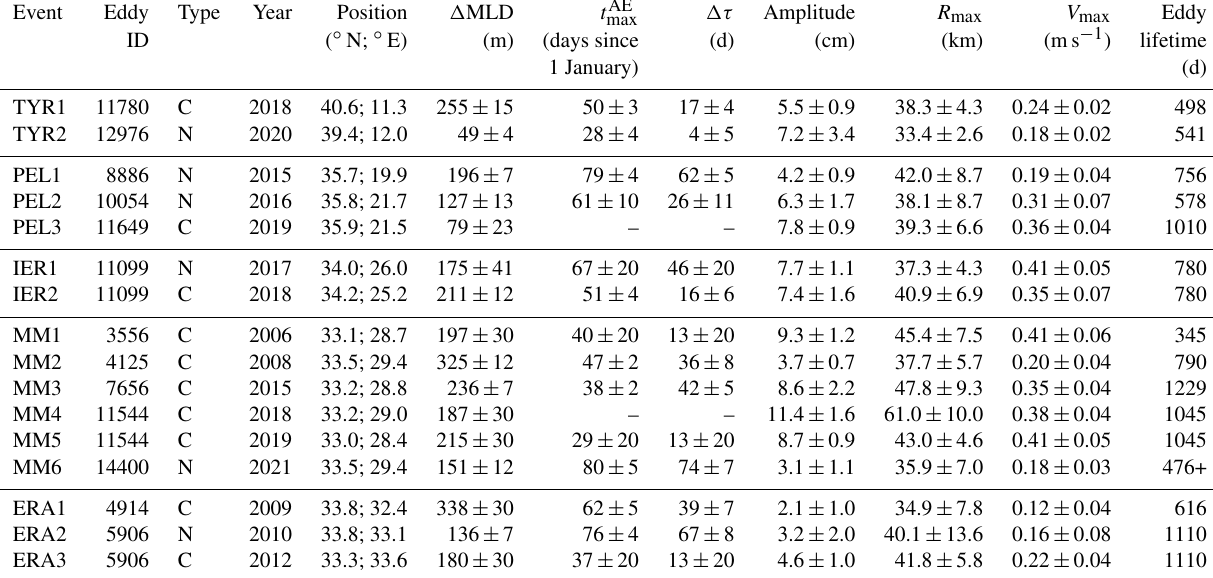
Figure 6. Map of well-sampled winter mixed-layer deepening events inside anticyclones listed in Table 1. Big dots show “connecting” events, while crosses show “non-connecting” ones. Colour depends on the region: Central Tyrrhenian (TYR), Pelops (PEL), Ierapetra (IER), Mersa Matruh (MM) and Eratosthenes (ERA, also called “Cyprus”). Isobaths shown on the maps are at 100, 500, 1000 and 1500m depth; topographic data from ETOPO1 (Smith and Sandwell, 1997). Table 1. Main characteristics of the 16 anticyclonic core mixed-layer deepening events studied; fitting method and uncertainties are detailed in Sect. 3.3. Eddy ID refers to track number in the DYNED-Atlas. Event types are “C” for “connecting” and “N” for “non-connecting”. Year “2018” corresponds to winter 2017–2018. Regions codes, ordered from west to east, stand for central Tyrrhenian (TYR), Pelops (PEL), Ierapetra (IER), Mersa Matruh (MM) and Eratosthenes (ERA). (cid:49) MLD, t AE max and (cid:49)τ are illustrated in Fig. 3. Note that sometimes two different winters are recorded in the same anticyclone (for example: “IER 1–2”) and that one eddy tracking (“MM 6”) stopped because the dataset finished in December